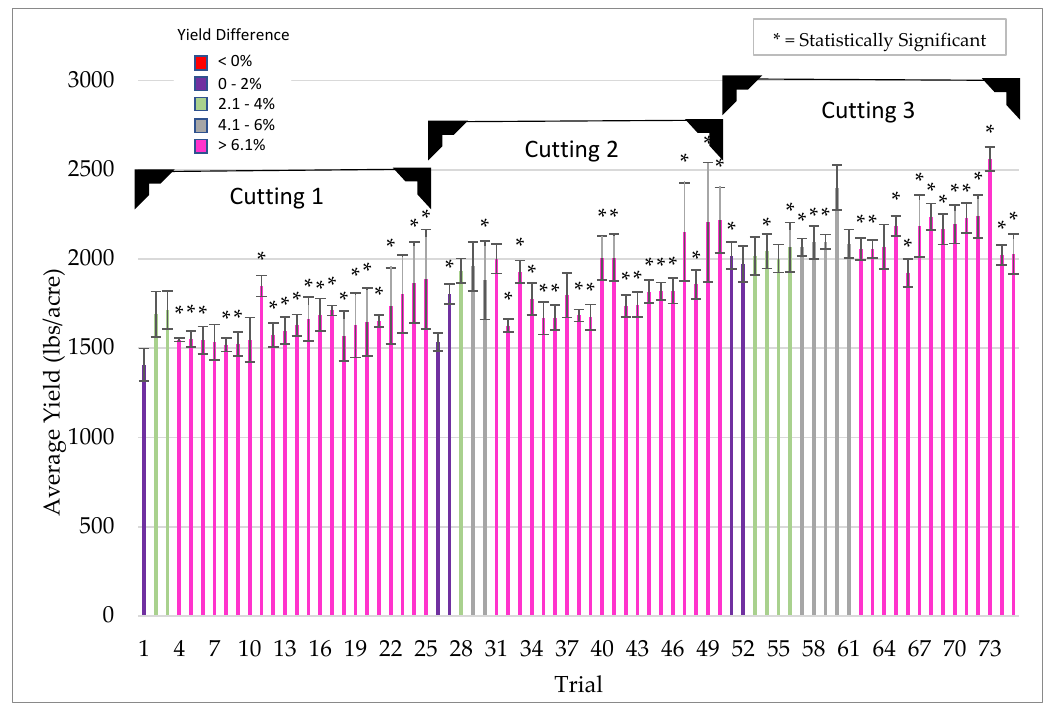
Figure 9. Winter wheat yield response (treated plants vs untreated controls) under low stress conditions. From 2017–2020, 62 trials were performed in three US states with commercial varieties/hybrids with Standard PPP’s. Each bar is a separate trial comparing yields of treated (ThMS3a) vs untreated plants with 4 – 8 replicates/trial. Plot sizes varied from 10 ft × 30 ft to 10 ft × 50 ft. Bars are color coded according to yield differences (Bu/Ac) indicated in the legend (upper right of graph). Bars with an asterisk symbol (*) indicate yield significance ( t test, p -value < 0.05). Cooperators: South Dakota State University, Agri-Tech Research, seed company. Under low stress, ThSM3a increased yields of alfalfa an average of 12.7% with a win rate of 85% (tests with yield increases above 5%) (Figure 10).